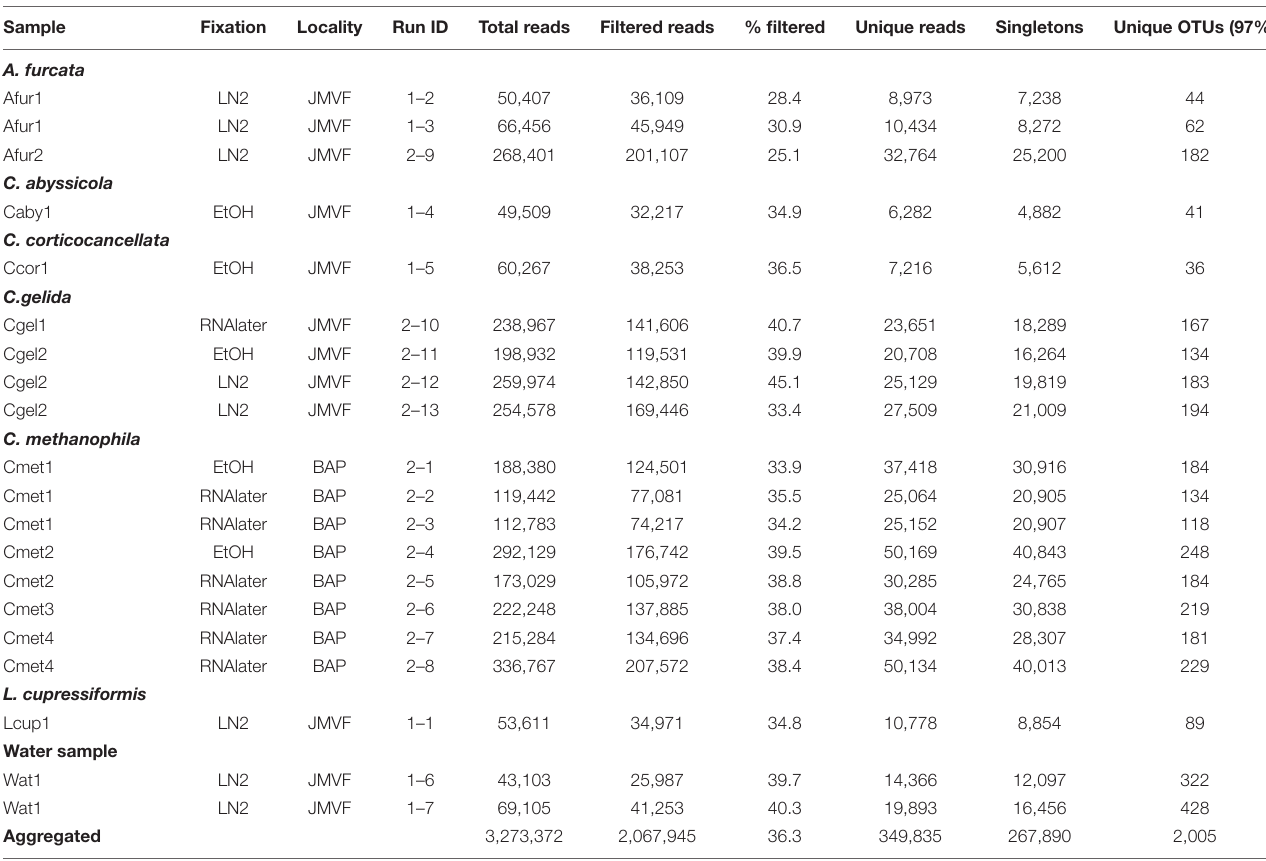
TABLE 3 | Dataset overview for 16S rRNA gene sequencing samples in this